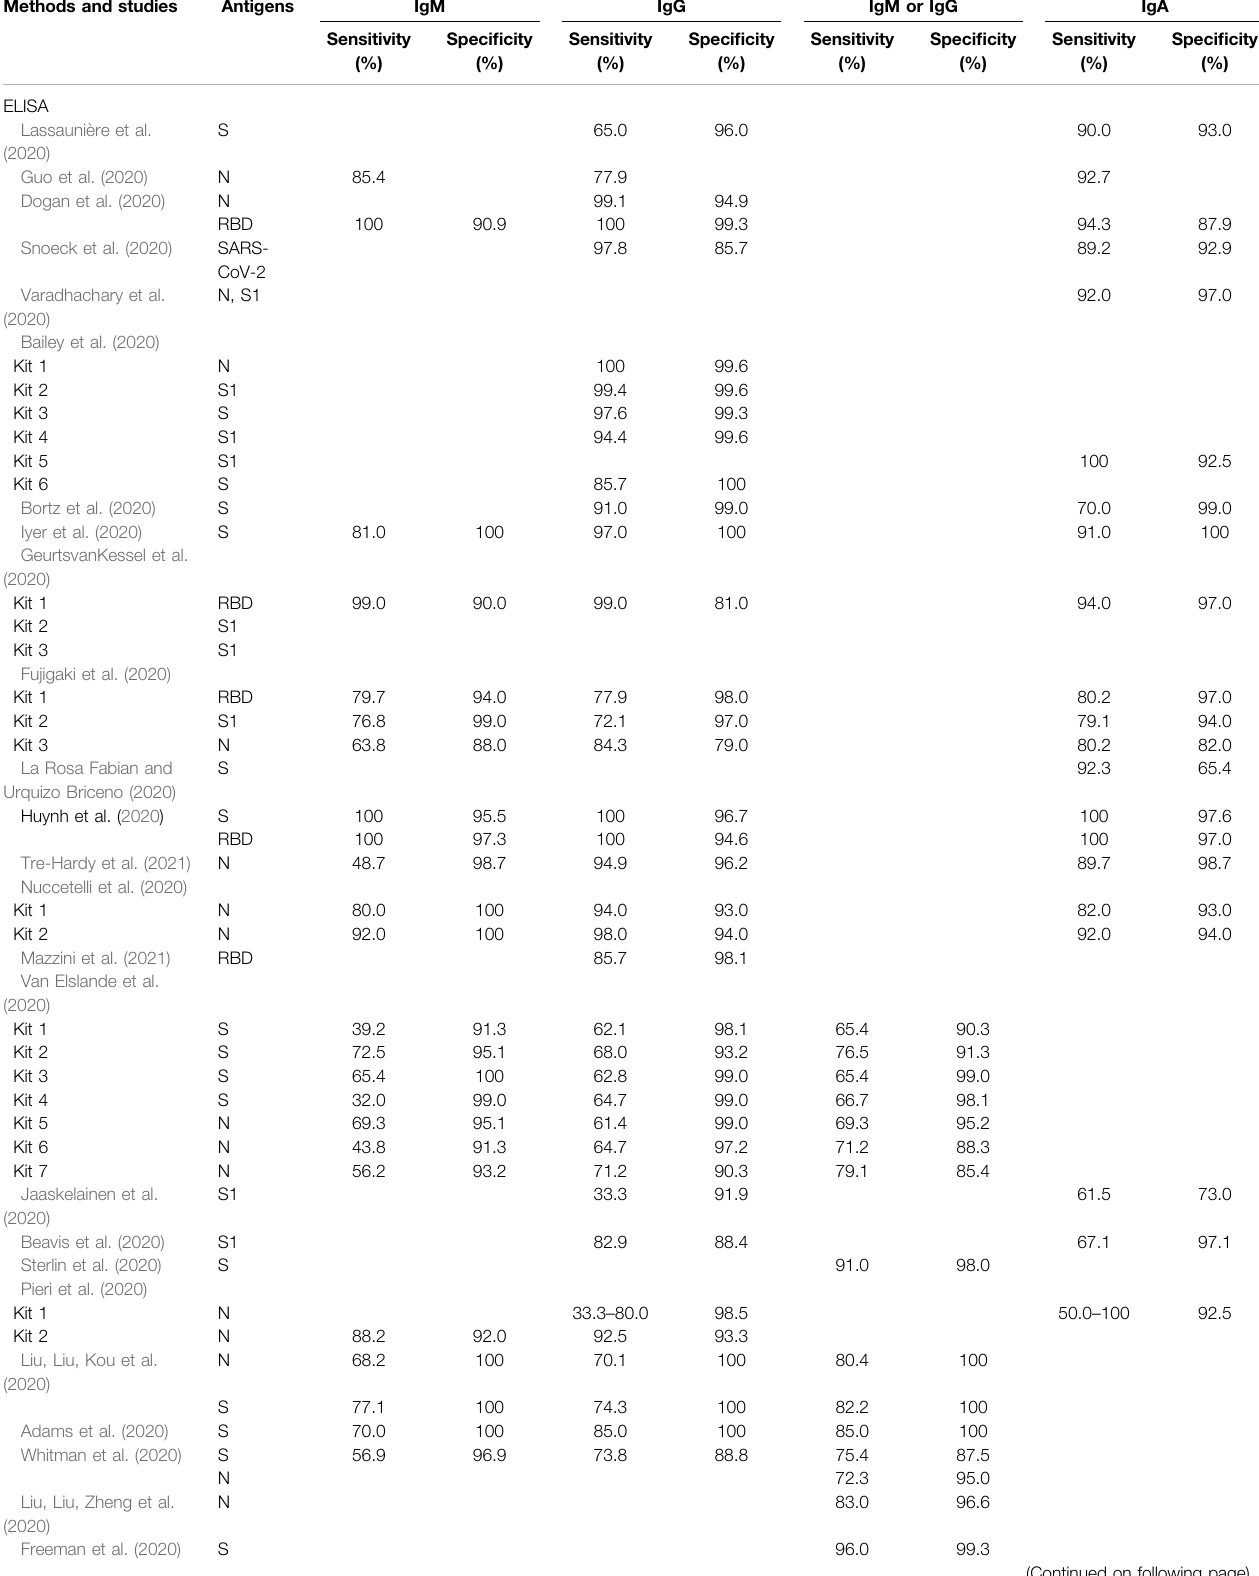
TABLE 1 | Summary of previous studies on sensitivity and speci fi city of COVID-19 serological diagnosis. Methods and studies